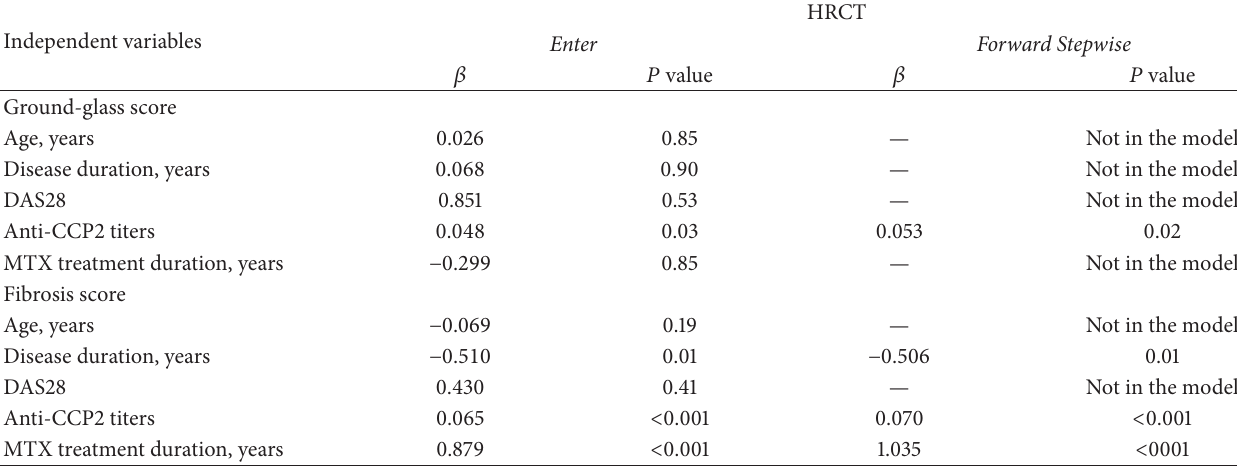
Table 4: Multiple linear regression analysis assessing the association of anti-CCP2 titers with the ground-glass and fibrosis scores observed in HRCT adjusting by selected